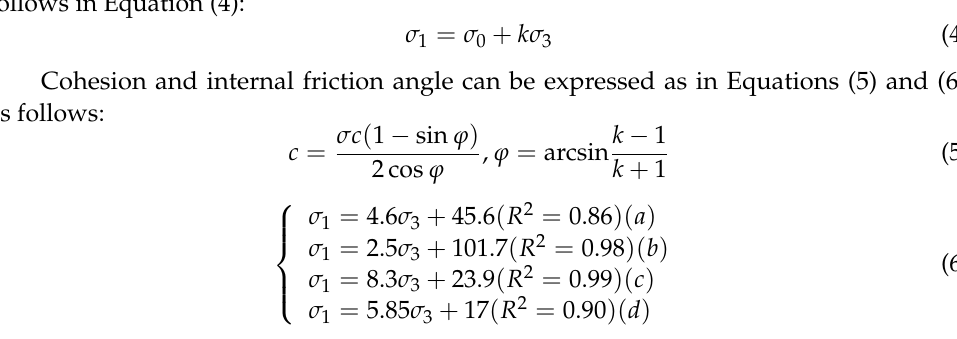
Figure 11. Triaxial test curve of mudstone, triaxial test curve of fine sandstone, triaxial test curve of fine sandstone, and triaxial test curve of medium sandstone.